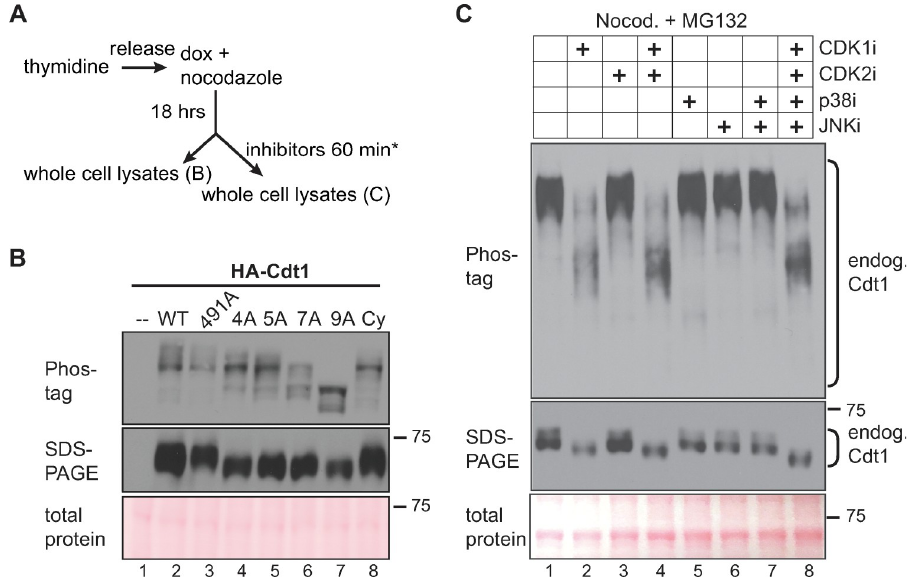
Fig 3. Cdt1 hyperphosphorylation is dependent on linker sites and CDK1 activity. A) Workflow for U2OS cell line synchronization and inhibitor treatment; inhibitors are indicated in 3C. B ) Whole cell lysates were separated by Phos- tag SDS-PAGE (top) or standard SDS-PAGE (middle) followed by immunoblotting for ectopic Cdt1 (HA); total protein stain serves as a loading control. C ) Cells were synchronized with nocodazole as in A, then mock treated or treated with 10 μ M RO-3306 (lane 2), 6 μ M CVT313 (lane 3), 30 μ M SB203580 (lane 5), 10 μ M JNK inhibitor VIII (lane 6), or combinations of inhibitors as indicated for 1 hour except that RO3306 treatment was for only the final 15 minutes to preserve mitotic cell morphology. All cells were simultaneously treated with 20 μ M MG132 to prevent premature mitotic exit. Endogenous Cdt1 phosphorylation was assessed by standard or Phos-tag SDS-PAGE followed by immunoblotting; total protein stain serves as a loading control. The example shown is representative of more than three independent experiments.